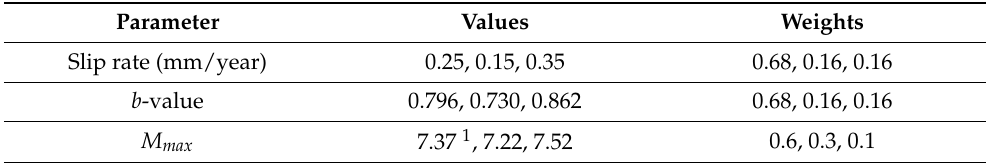
Table 1. Logic-tree parameter values and associated weights of the magnitude model for the Leech River Valley Fault. Parameter values and weights were adopted from